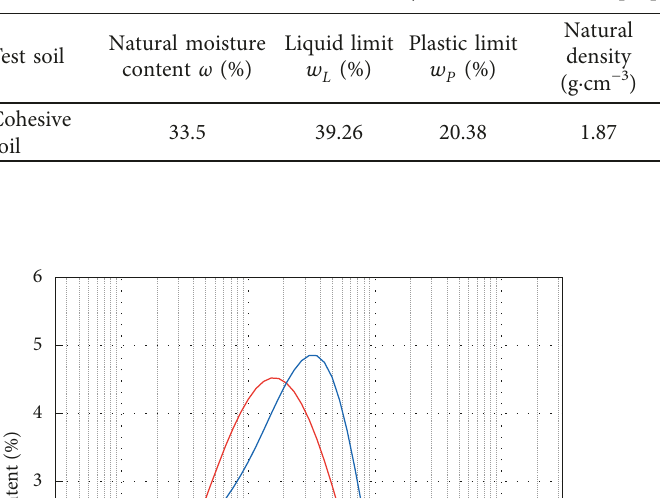
Table 2: Physical and mechanical property indexes of soil for test.